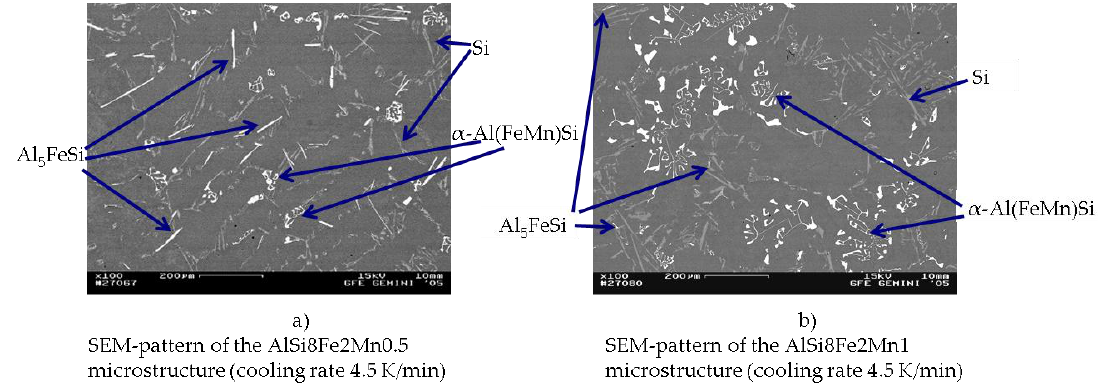
Figure 6. SEM pattern of the microstructure.